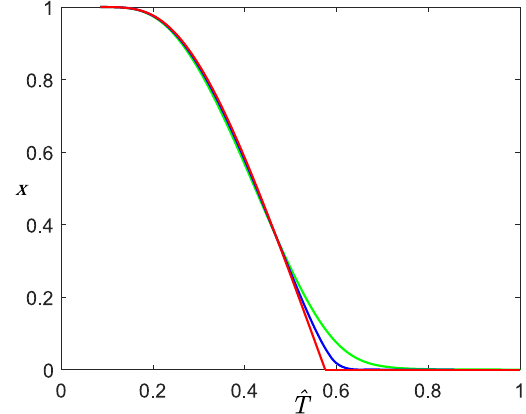
FIG. 6. Fraction of polymerized monomers as a function of temperature for different degrees of polymerization. Green curve corresponds to N ¼ 10 , blue curve to N ¼ 30 , and red curve to N → ∞ . The polymerization in the limit N → ∞ is equivalent to a continuous (second-order) phase transition in zero